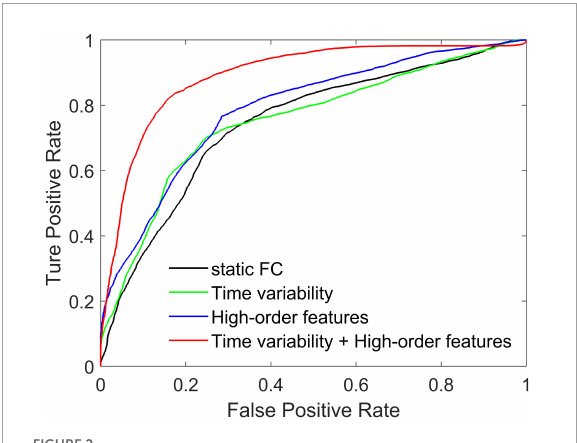
FIGURE2 Receiver operating characteristic curves achieved by four different methods in SZ vs. HC